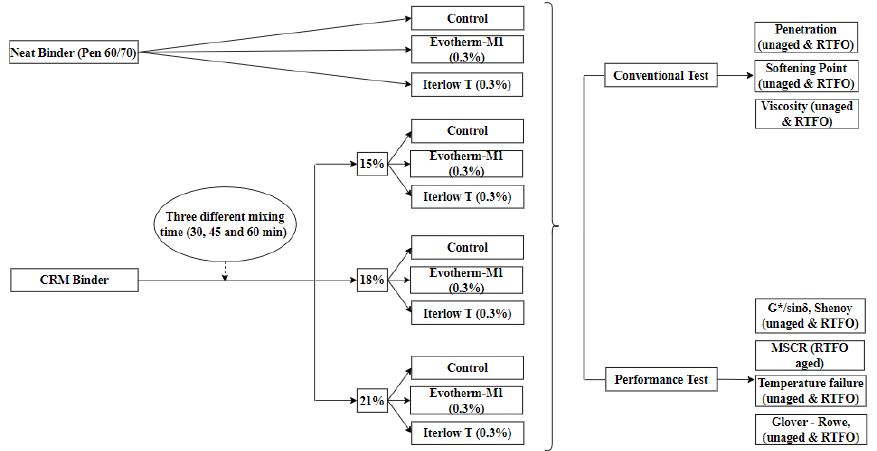
Figure 4. Experimental design used in this research.